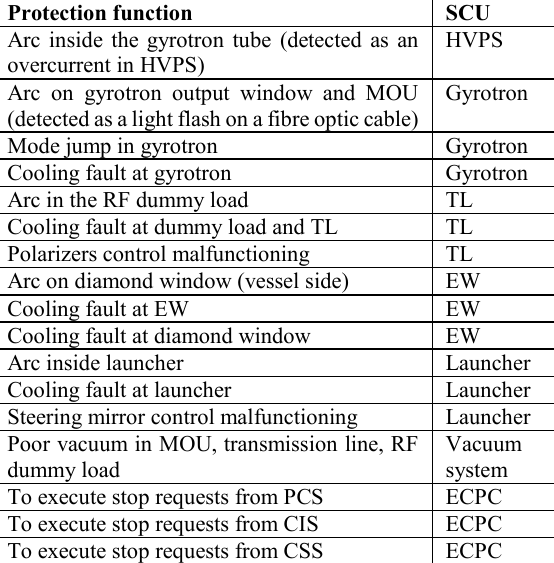
Table 1. List of protection functions.